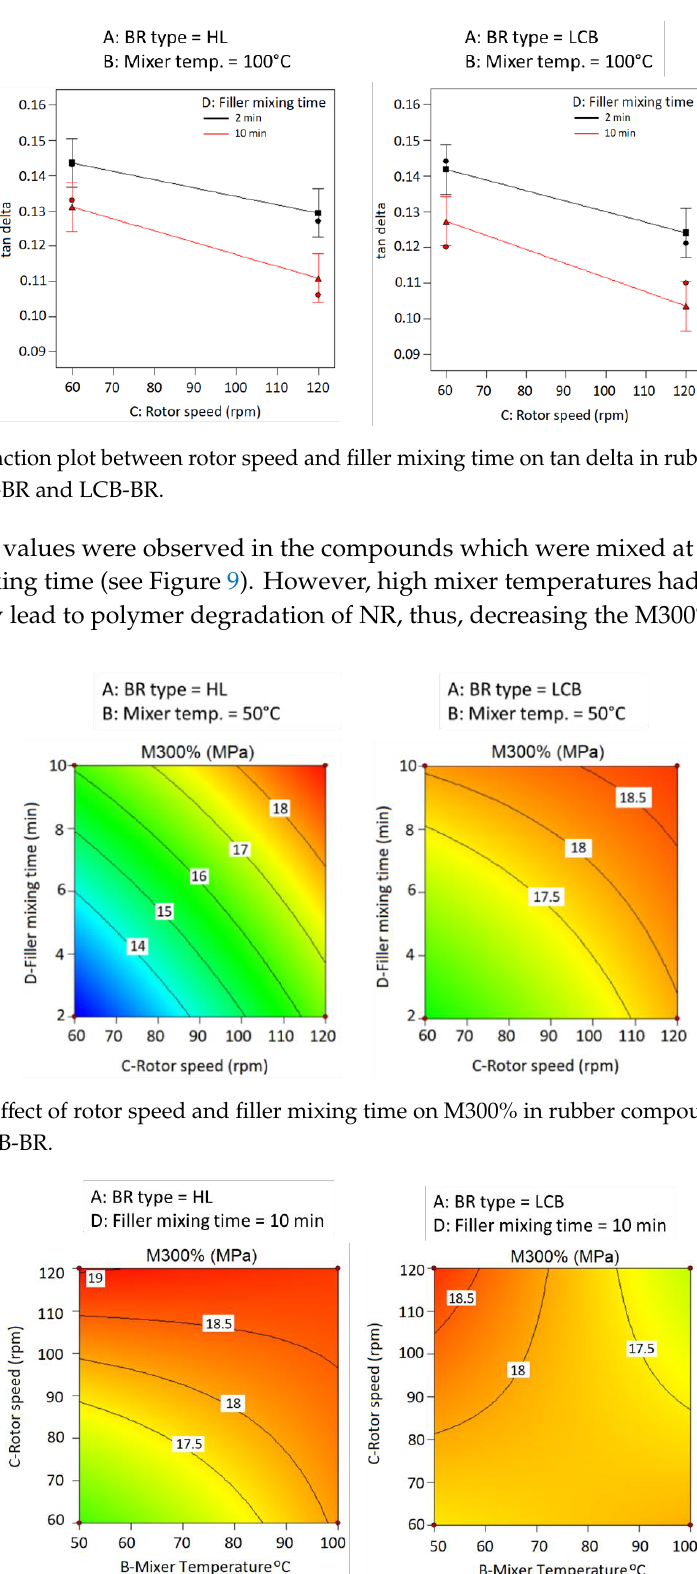
Figure 10. The effect of mixer temperature and rotor speed on M300 in rubber compounds containing HL-BR and LCB-BR .